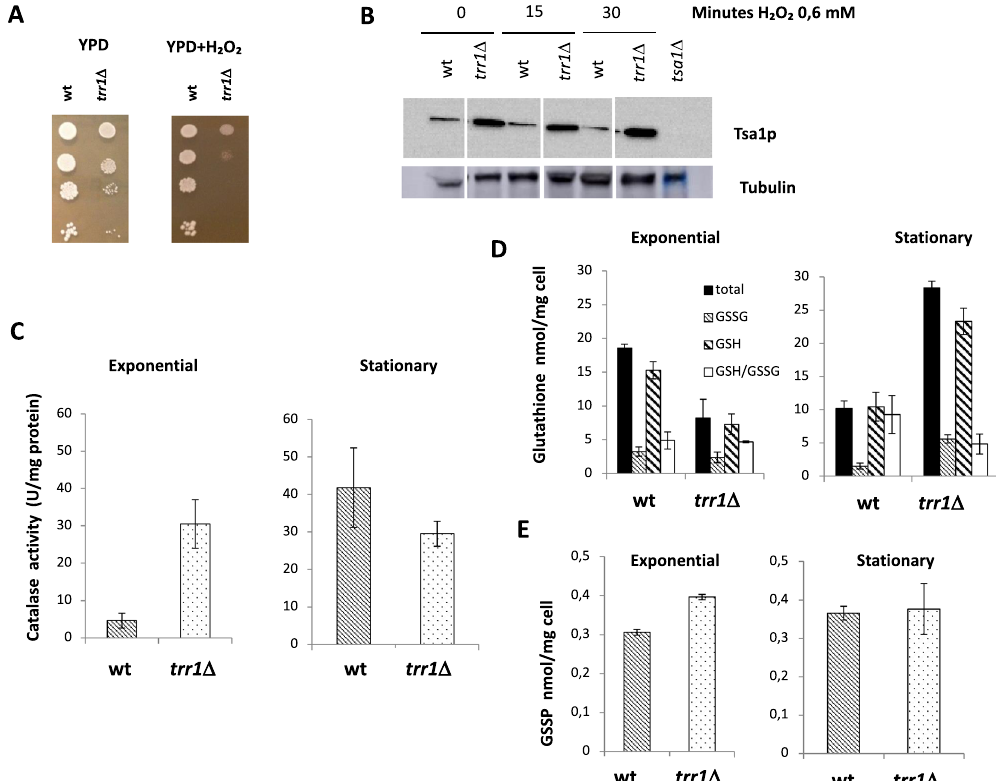
Figure 2. Trr1p plays a complex role in redox homeostasis. ( A ) Spot assays of the wine yeast C9 mutants and the trr1 Δ mutant on YPD plates containing 3 mM H 2 O 2 . ( B ) Western blot against peroxiredoxin of both strains under hydrogen peroxide stress. Tubulin was used as a loading control. The picture was cropped to remove an unrelated mutant, marked with gaps (Supplementary Fig. S2). ( C ) Catalase in the exponential and stationary phase of growth in rich YPD medium in the wild type and mutant strain. ( D ) Quantification of reduced, oxidized and total glutathione under the same conditions as panel. ( C , E ) Protein-bound glutathione under the same conditions. Experiments were done in triplicate. The mean and standard deviation are